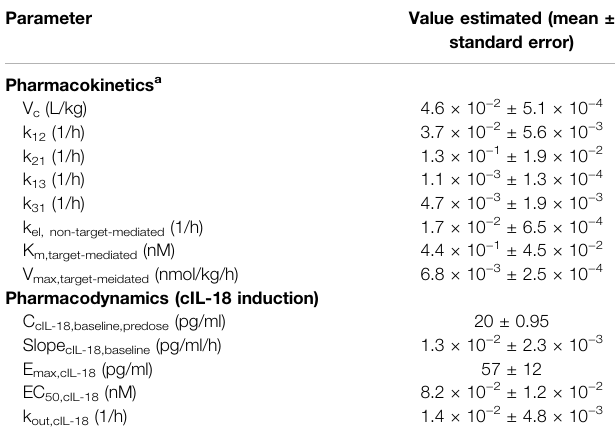
a Toaccountforthedrugexposurelossasaresultofantidrugantibodies,individualdose reduction factors were used. For the 0.06-mg/kg dose, the dose reduction factors after the 2nd and 3rd dose estimated from fi tting the data were 3.0 ± 0.53 and 4.9 ± 2.8, respectively; for the 0.18-mg/kg dose, the corresponding dose reduction factors were 2,530 ± 714 and 380 ± 69, respectively. Please see Section 2.5.3 for the rationale and estimation